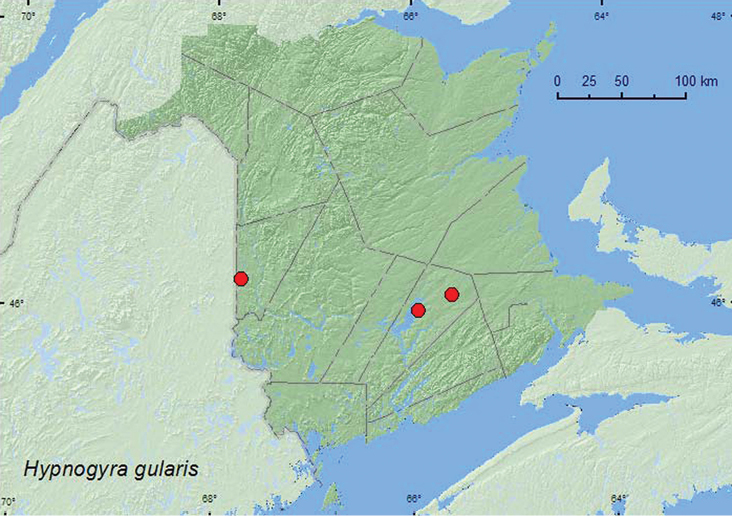
Collection localities in New Brunswick, Canada of Hypnogyra gularis.